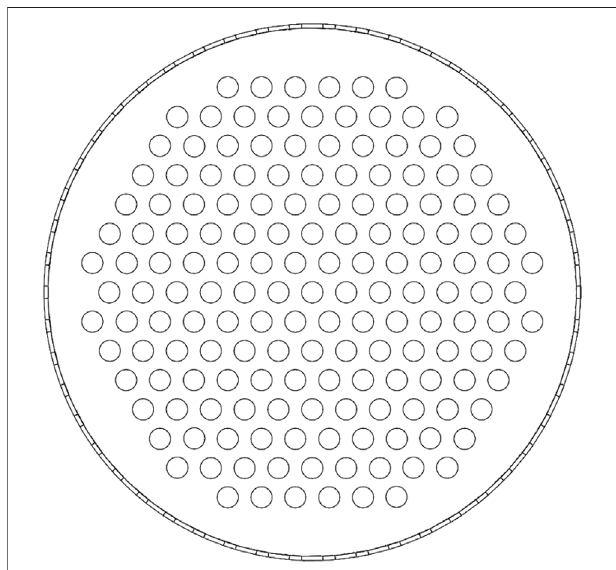
FIGURE 6 | Arrangement of circular holes on the end